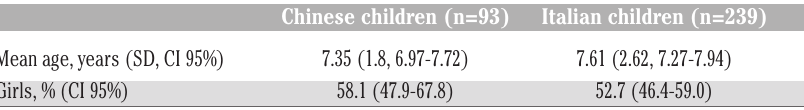
Table 1. Differences between the two groups of children undergoing venipuncture with regard to ethnicity, gender and age.